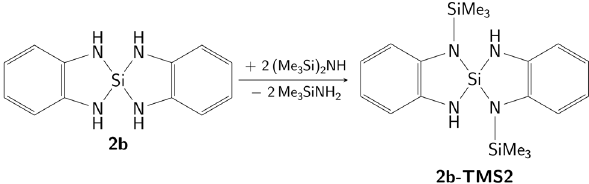
Figure 12: Molecular structure of 4g including numbering scheme (top). The thermal displacement ellipsoids of the non-hydrogen atoms are drawn at the 50% probability level. Schematic formula drawing of 4g (bottom). The bonding situation of the silicon atoms is colour coded (see text for